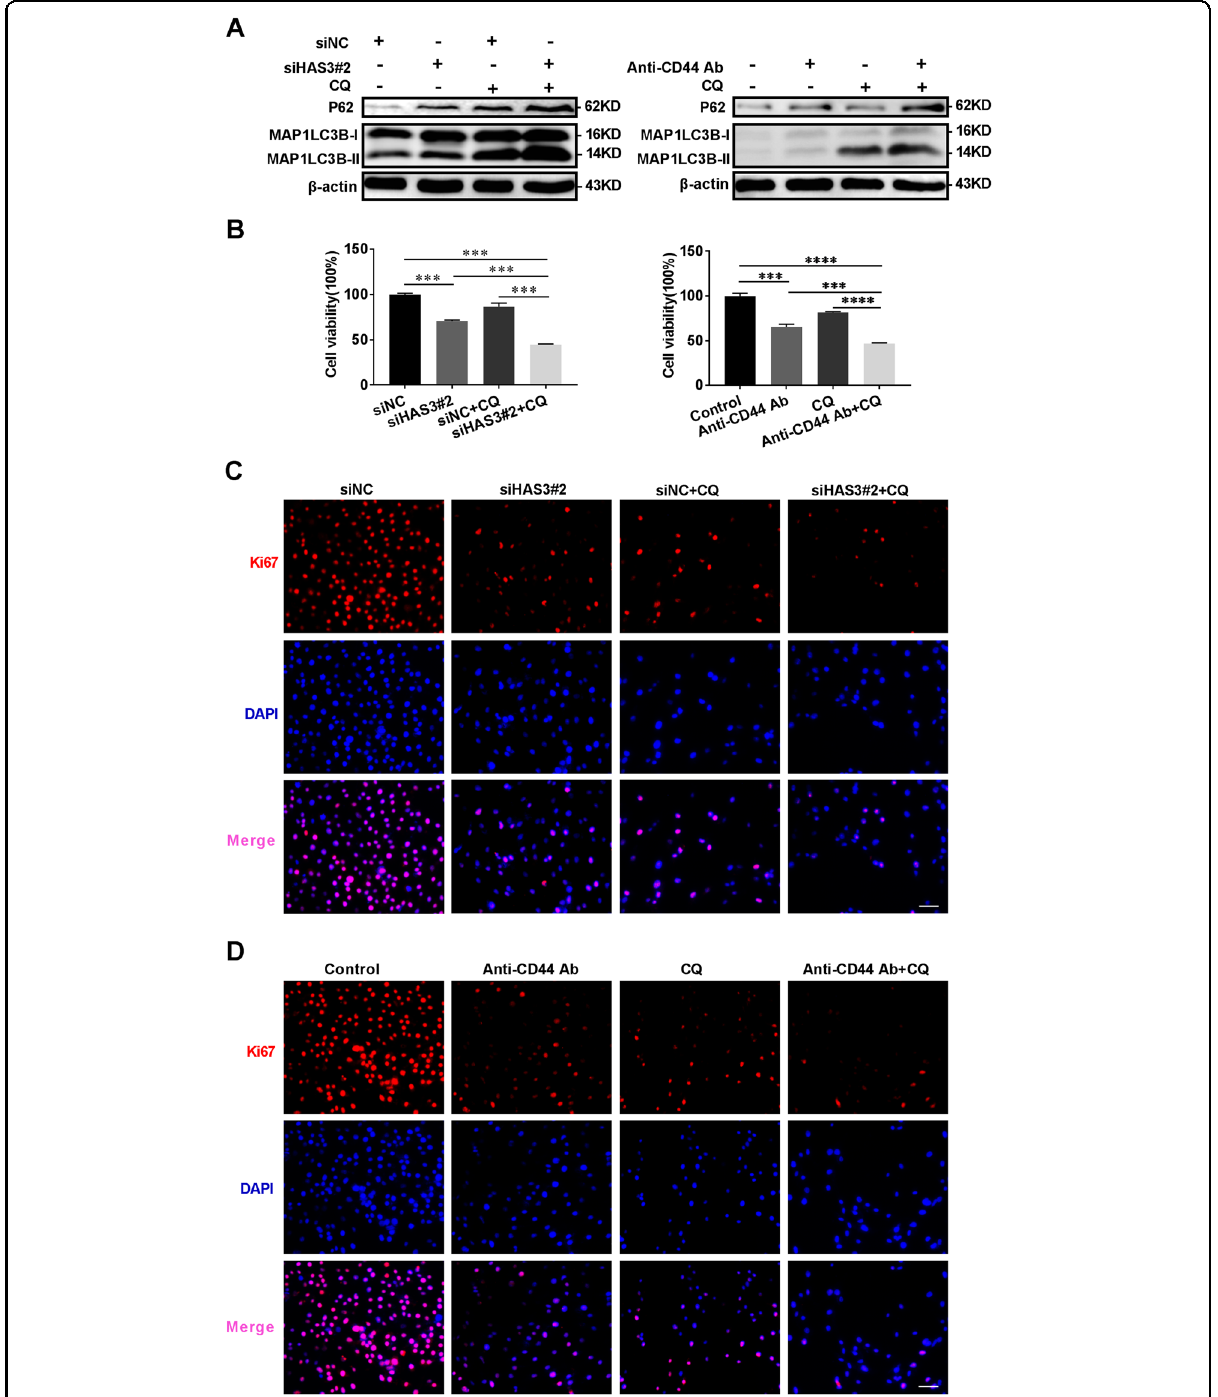
Fig. 4 Treatments interfering with HAS3 and CD44 combined with autophagy inhibitors exert synergistic effects on glioma cell viability and autophagy levels. A Relative levels of the P62 and MAP1LC3B proteins in U251 glioma cells transfected with the HAS3 siRNA or cultured with a CD44 antibody, followed by treatment with CQ (30 μ mol/L) for 48 h. B Viability of U251 glioma cells transfected with the HAS3 siRNA or cultured with a CD44 antibody, followed by treatment with CQ (30 μ mol/L) for 48 h. C – D Levels of the Ki67 protein in U251 glioma cells were detected using immuno fl uorescence staining after transfection with the HAS3 siRNA or culture with a CD44 antibody, followed by treatment with CQ (30 μ mol/L) for 48 h. Scale bar: 50 μ m. The data are presented as the mean ± SD; * P < 0.05, ** P < 0.01, and *** P < 0.001, **** P <